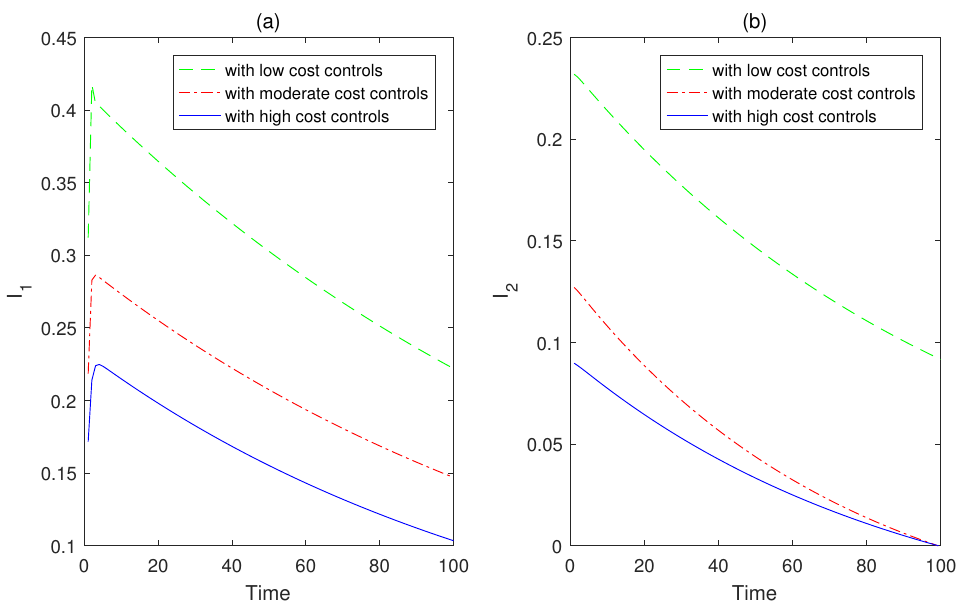
Figure 5. The weight parameter values with respect to disease infection and the cumulative number of media coverage are set as γ 11 = 3.5, γ 13 = 5, and three scenarios are as follows, (i) low optimal cost controls: γ 12 = γ 21 = γ 22 = 0.35; (ii) moderate optimal cost controls: γ 12 = γ 21 = γ 22 = 3.5; (iii) high optimal cost controls: γ 12 = γ 21 = γ 22 = 35. ( a ) The total number of infected individuals with respect to time at the acute stage. ( b ) The total number of infected individuals with respect to time at the chronic stage.